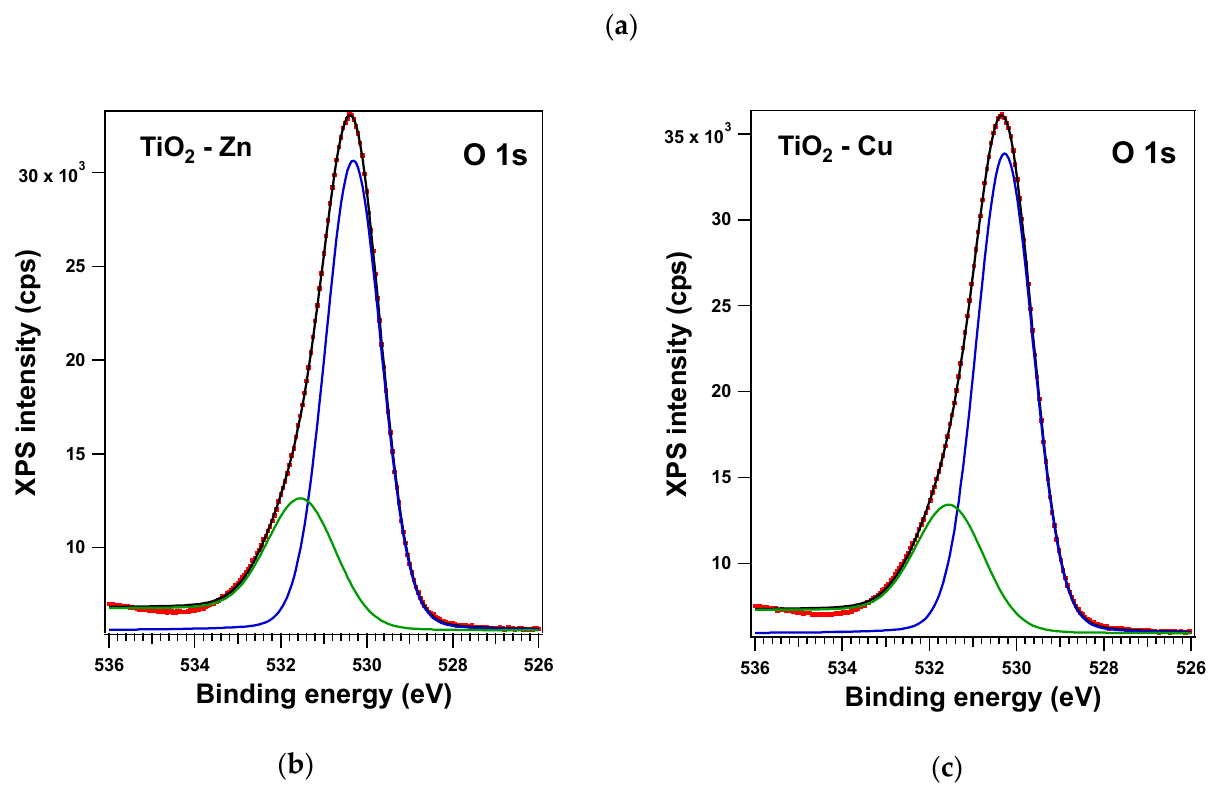
Figure 6. XPS spectra of the O 1s level: ( a ) experimental data for the Zn (red line)- and Cu (blue line)-doped samples and red symbols for the experimental data overlayed with a black line for the fit and deconvolutions for ( b ) the Zn sample and ( c ) the Cu sample: blue line for C1 and green line for C2.